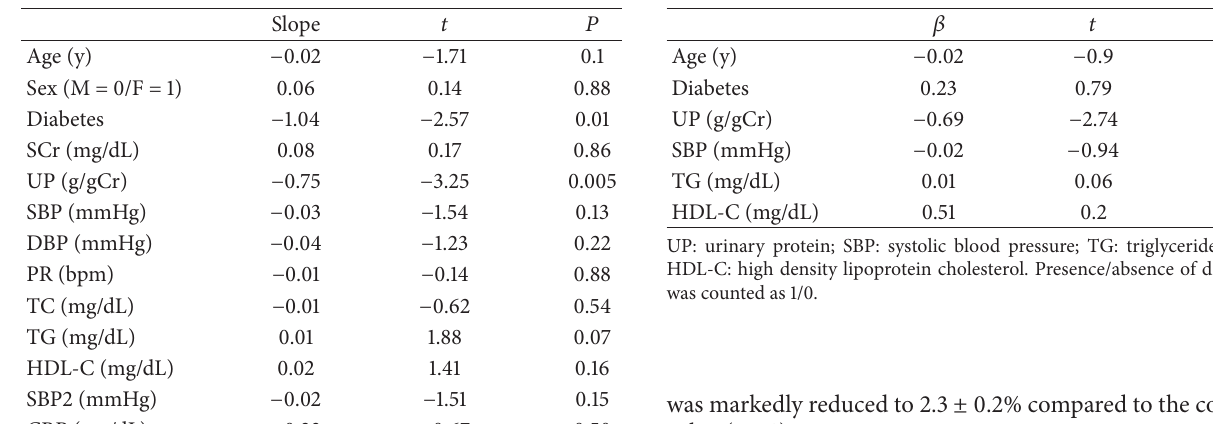
Table 2: Simple regression to flow-mediated dilation. Table 3: Multivariate regression to flow-mediated